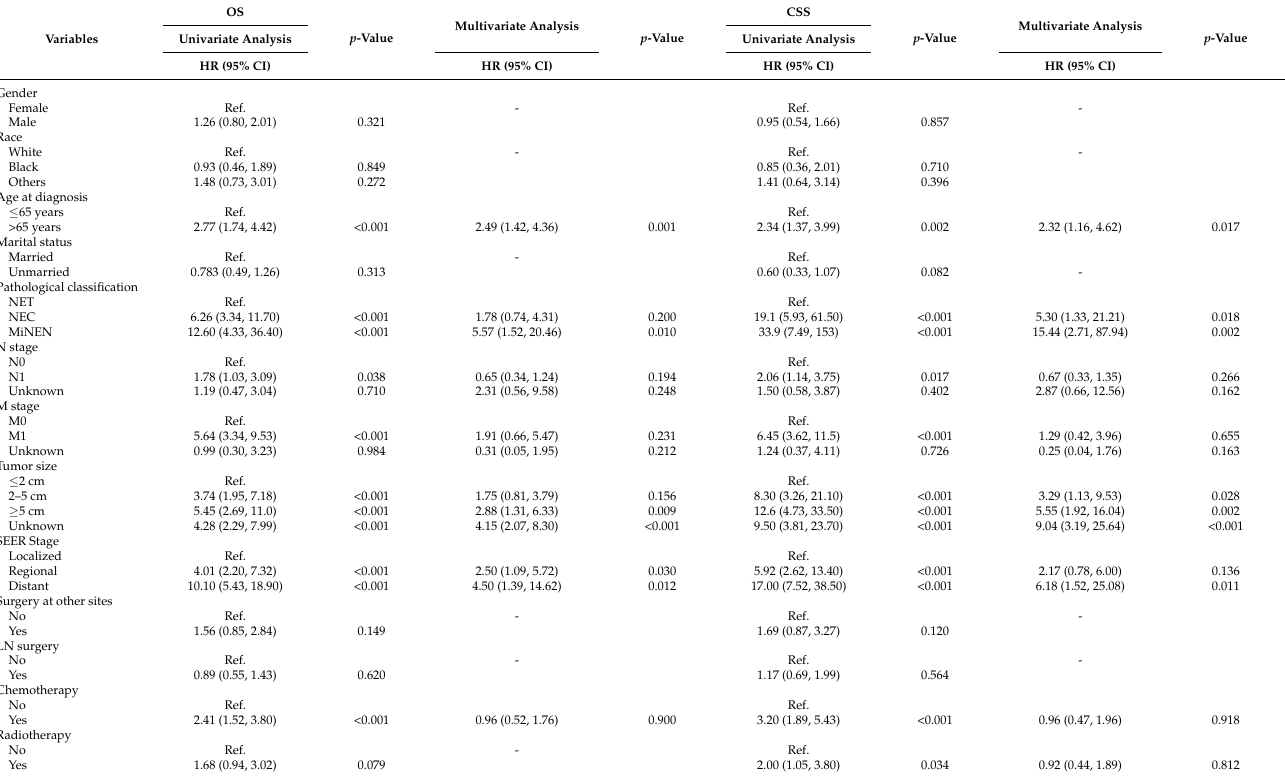
Table 2. Univariate and multivariate Cox regression analyses of OS and CSS in training